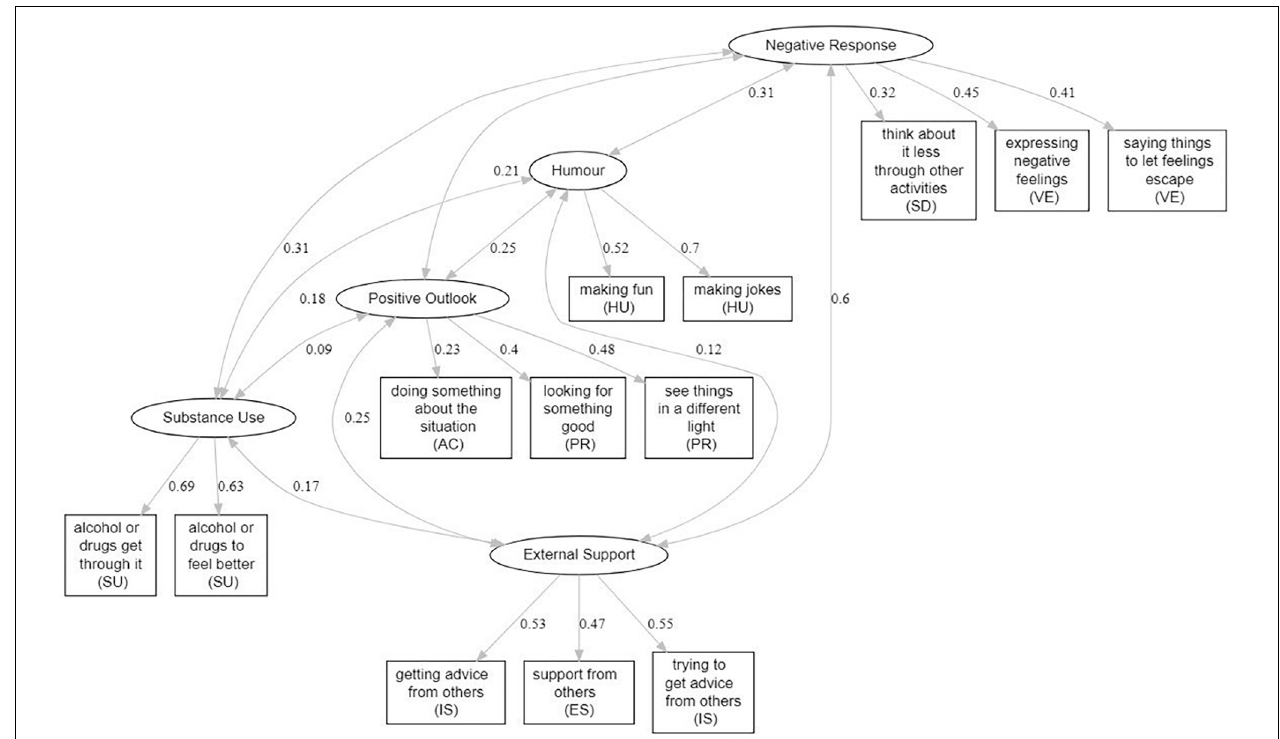
FIGURE 1 | Model plot of COPE model based on CFA. Numerical values beside downward arrows indicate parameter estimates. Numerical values beside bi-directional arrows indicate covariances between